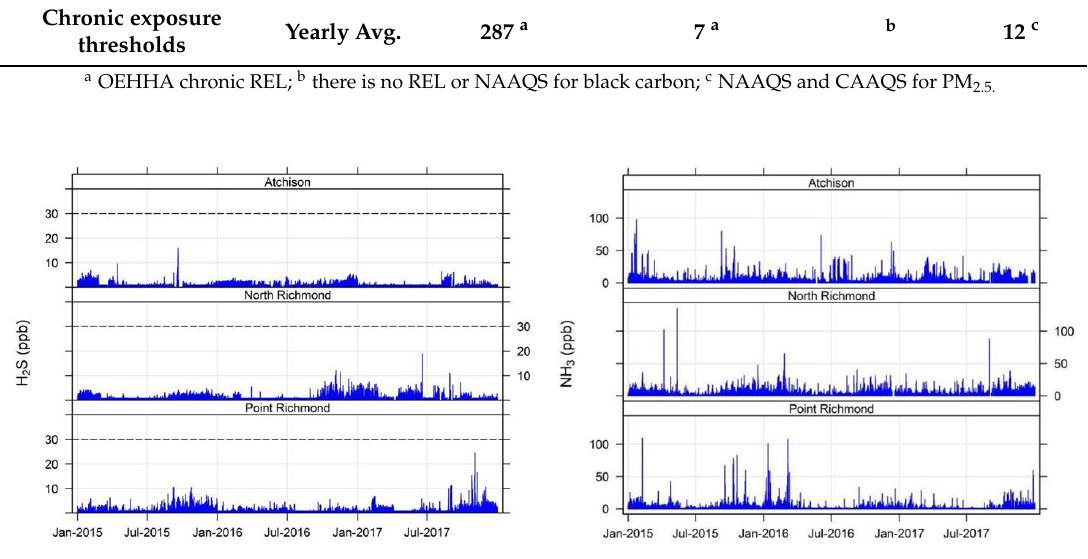
Figure 3. Hydrogen sulfide and ammonia 1-h average concentration (ppb) at the three community monitoring stations, including Point Richmond, North Richmond and Atchison Village. California OEHHA 1-h RELs for these gases are 30.1 ppb for H 2 S (represented by the dashed line) and 3200 ppb for NH 3 (not shown in the Figure). Non-detect data (below a detection of 2 ppb for H 2 S and NH 3 ) were replaced with one-half the detection limit (1 ppb).